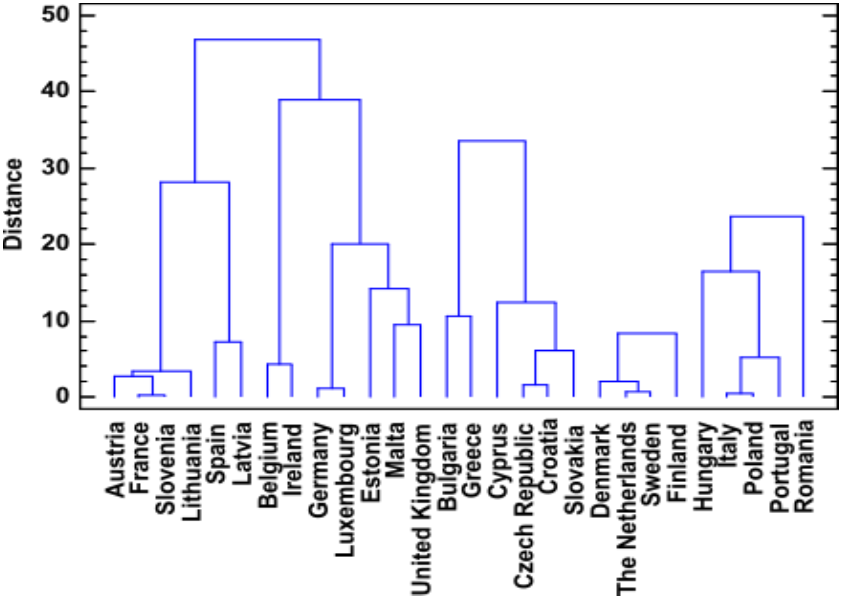
the years analyzed, both for DESI and for the components separated within it. Detailed Figure 3. Ward’s dendrogram for the EU-28 Member States in 2020. Source: Our own study. Figure 3. Ward’s dendrogram for the EU-28 Member States in 2020. Source: Our own study. data on the average values of indicators for particular clusters are presented in Figure 4.